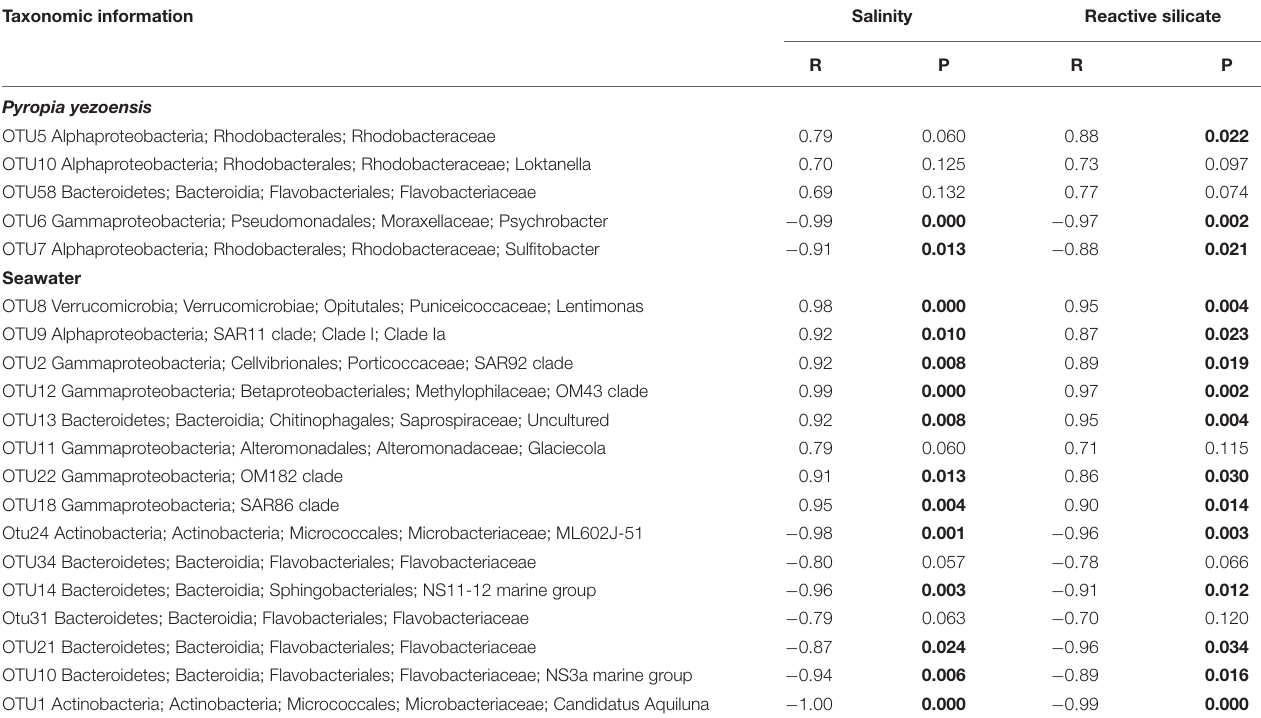
TABLE 3 | Pearson’s correlation coefficients between health-status related bacterial taxa and environmental